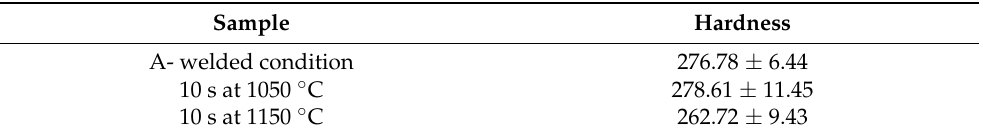
Table 2. Average hardness value for each